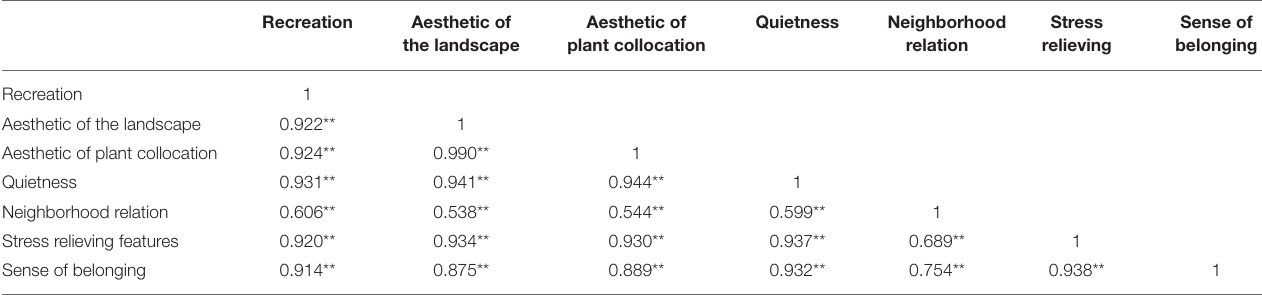
TABLE 3 | Pearson’s correlation coefficient of the different CES.